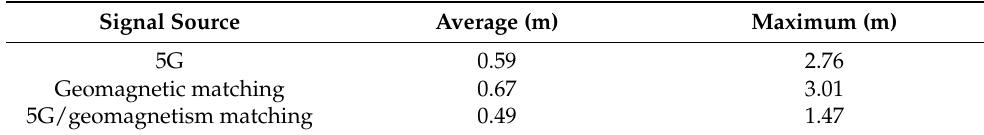
Figure 12. CDF of positioning errors with different method, blue is the 5G positioning result, red is the geomagnetic positioning result and green is the fusion positioning result. Table 2. Position error comparison.